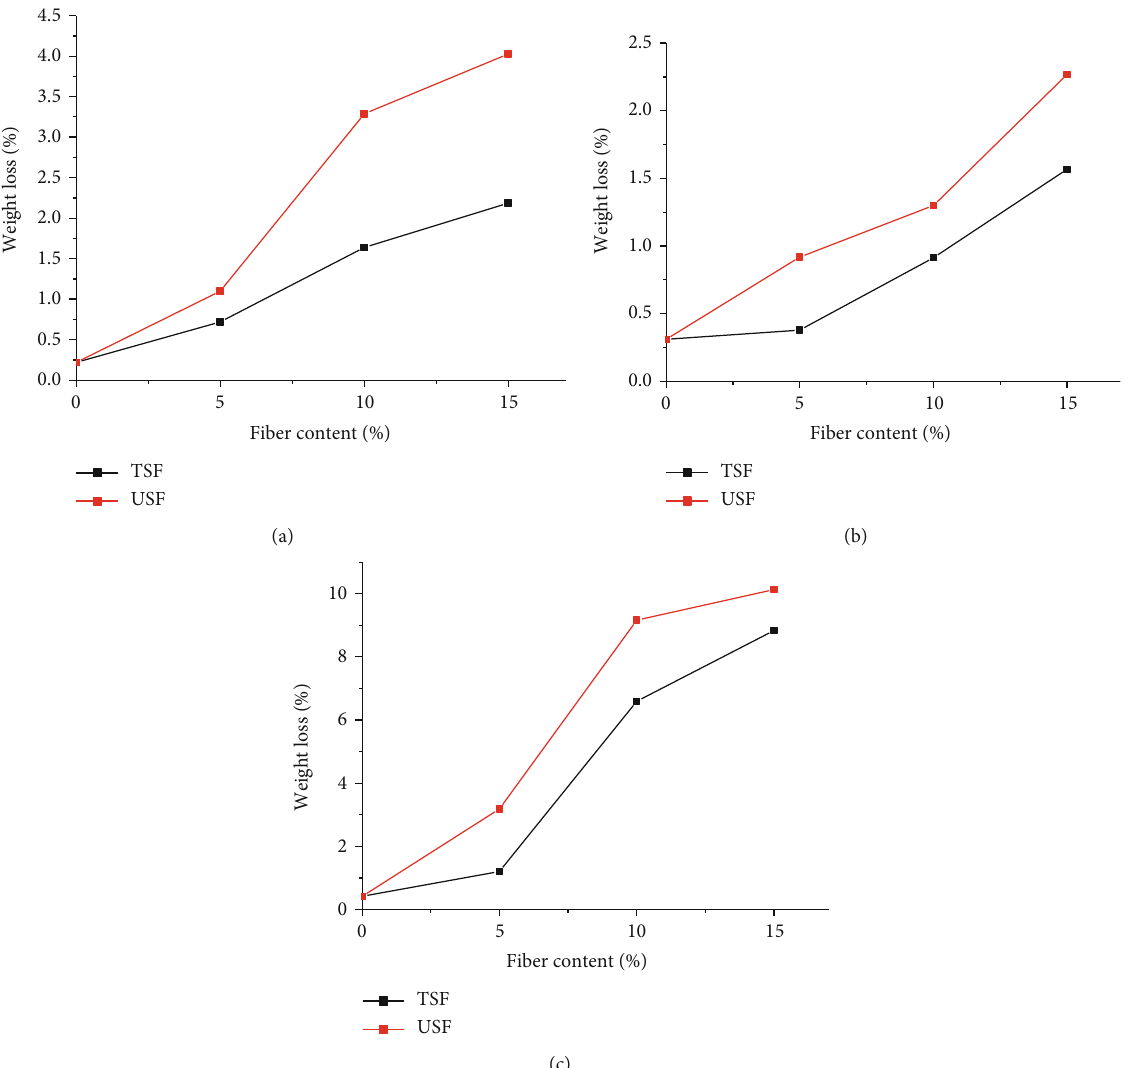
Figure 9: Percentage weight loss of composites in (a) 30% NaOH, (b) 30% HCl, and (c) 30% H